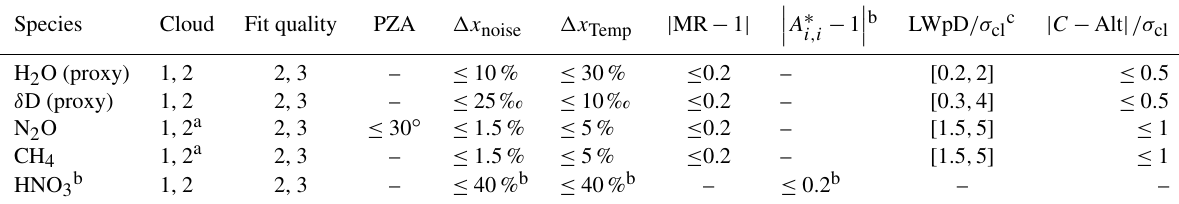
Table 4. Filters applied for the time series and global daily maps of different species and for different altitudes (Alt) as shown in Figs. 14 and 15: EUMETSAT L2 PPF cloudiness assessment summary flag, MUSICA spectral fit quality flag, platform, zenith angle, MUSICA noise and temperature error, and MUSICA averaging kernel metrics (measurement response: MR; diagonal value of the partial column averaging